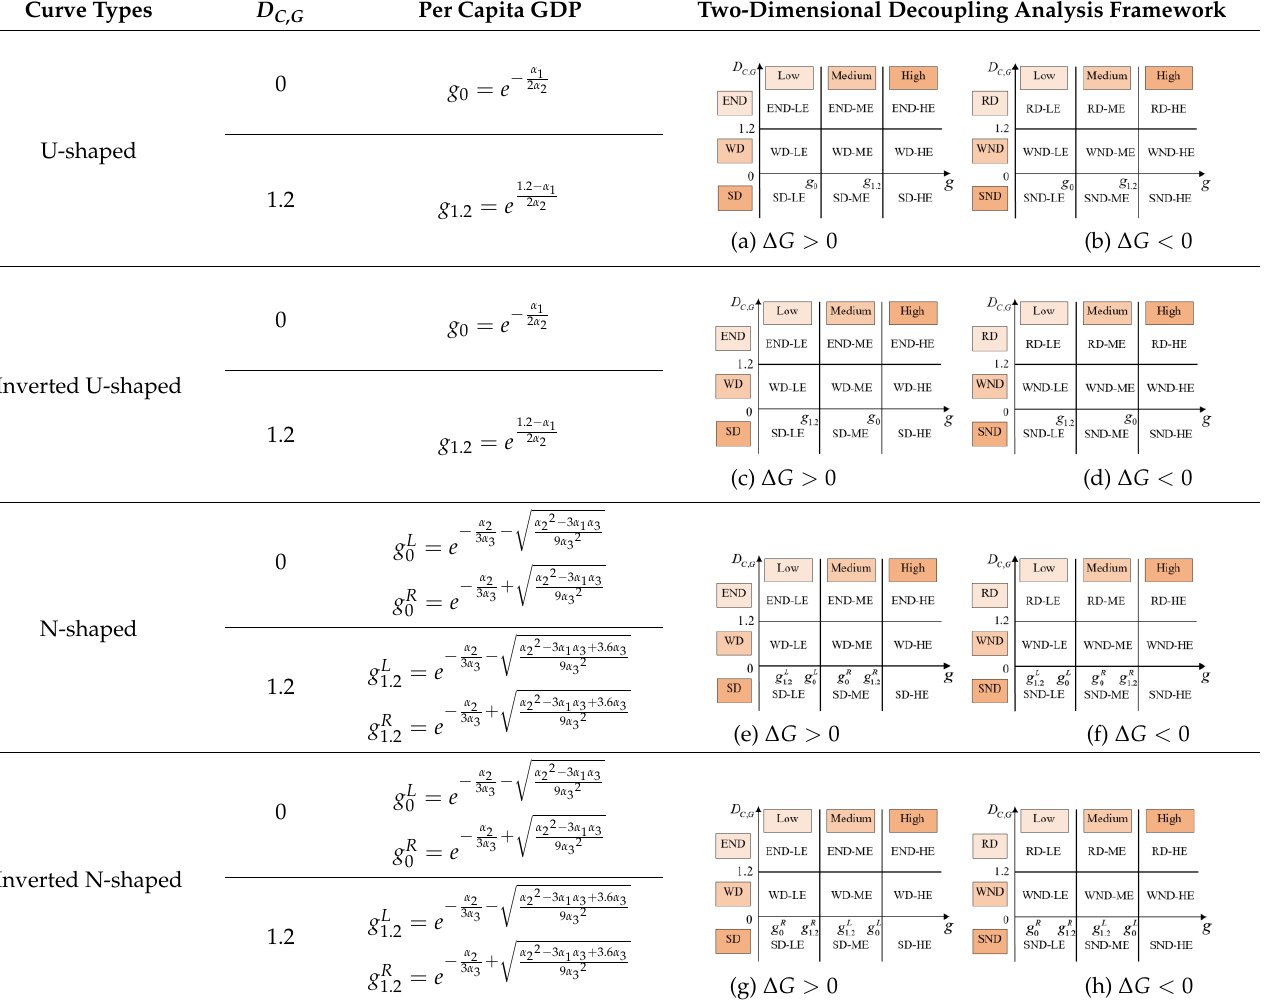
Table 2. A general two-dimensional decoupling analysis framework.